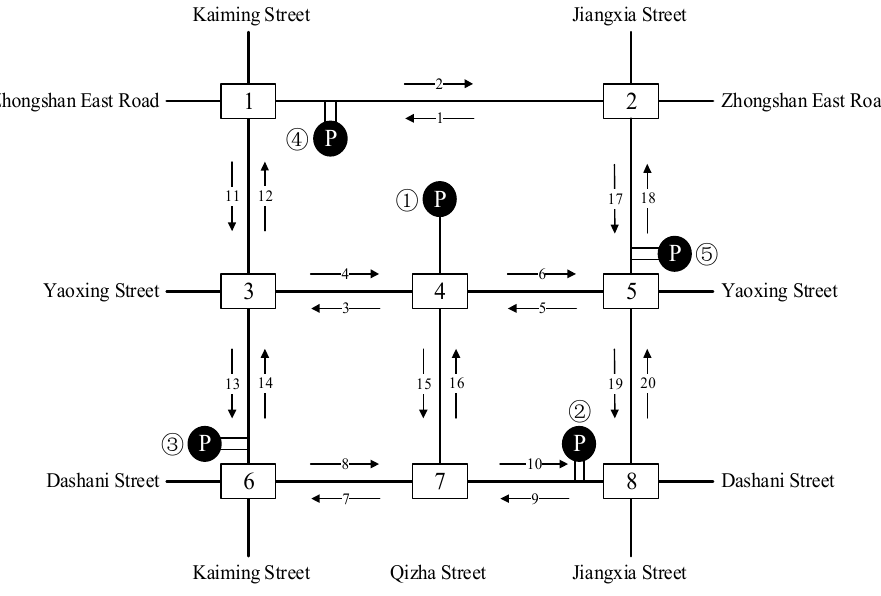
Figure 5. Simulated road traffic network.